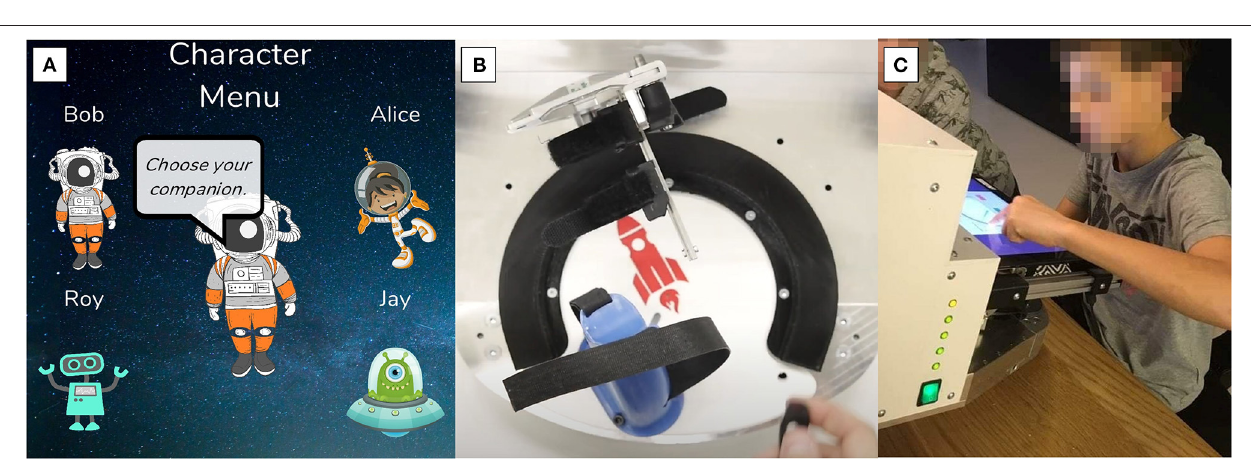
FIGURE 3 | Adaptation of the GUI and of the handles to make the assessment platform more suitable for children. (A) The GUI was transformed into a space-theme. At the start of the assessment, children can choose a character that then provides instructions and encouraging messages throughout the assessment. (B) The handle was designed with brighter colors and an image of a rocket to match the overall theme. The handle position was made adaptable for different hand sizes. (C) A child interacting with the GUI completing the passive position sense